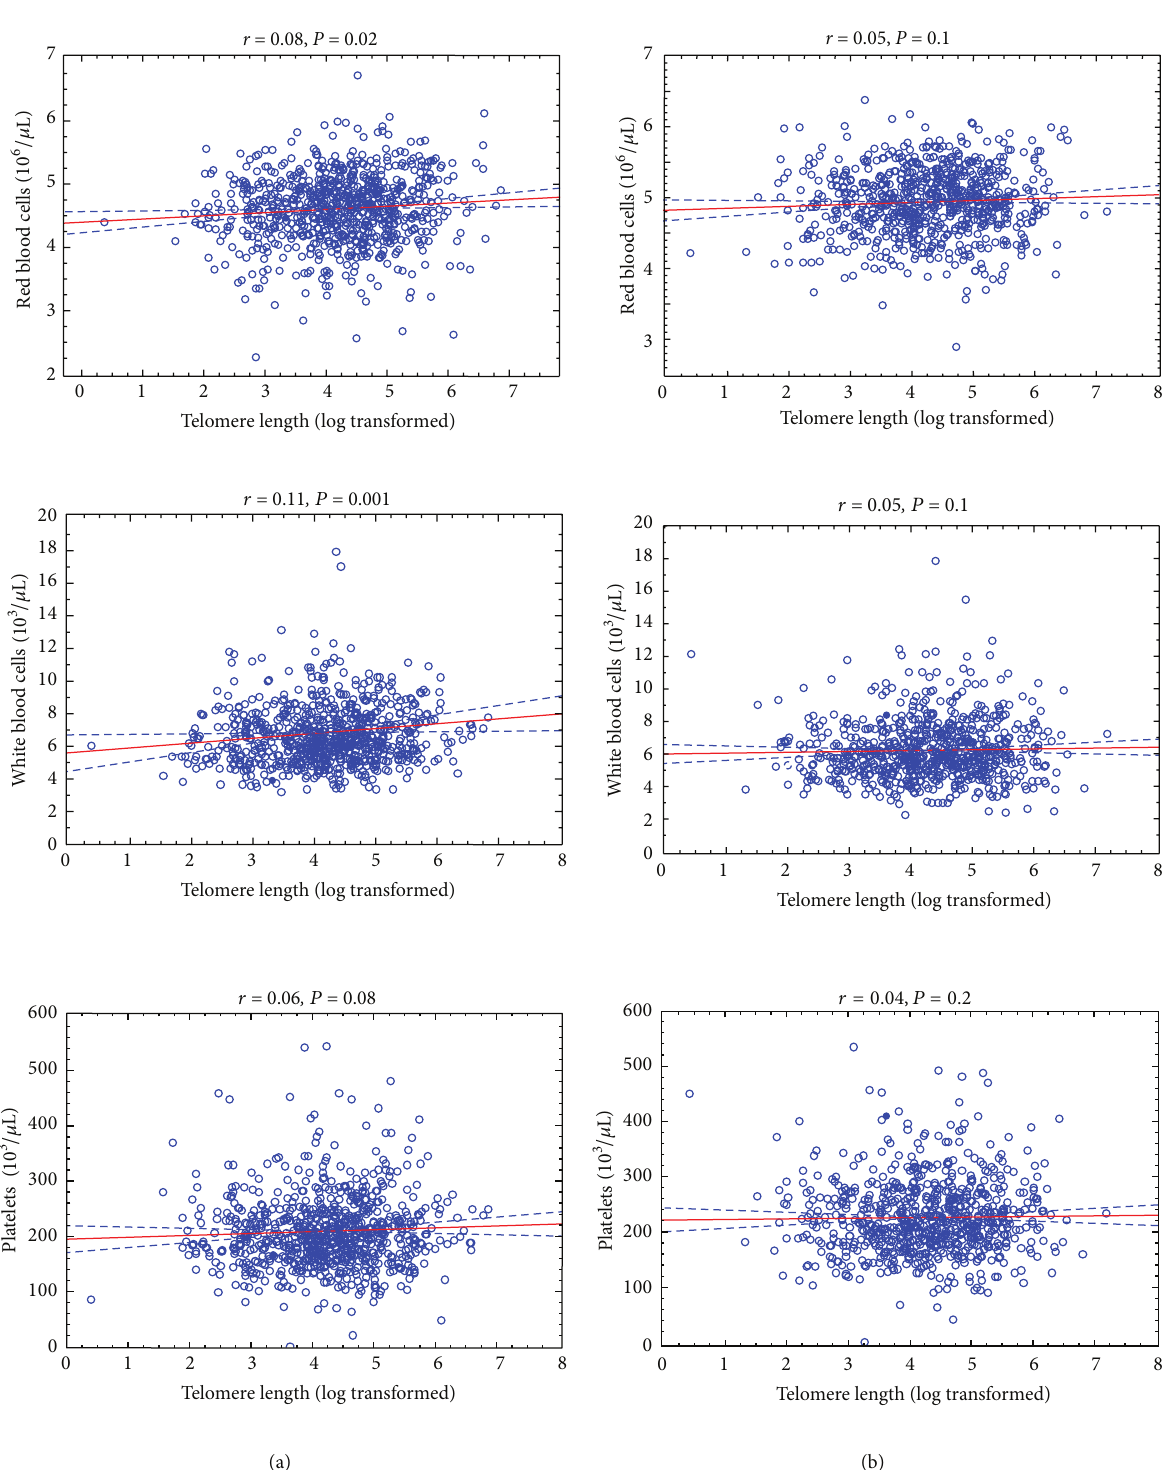
Figure 1: Correlation between telomere length and peripheral blood count (red blood cell, white blood cell, and platelets) in men (a) and women